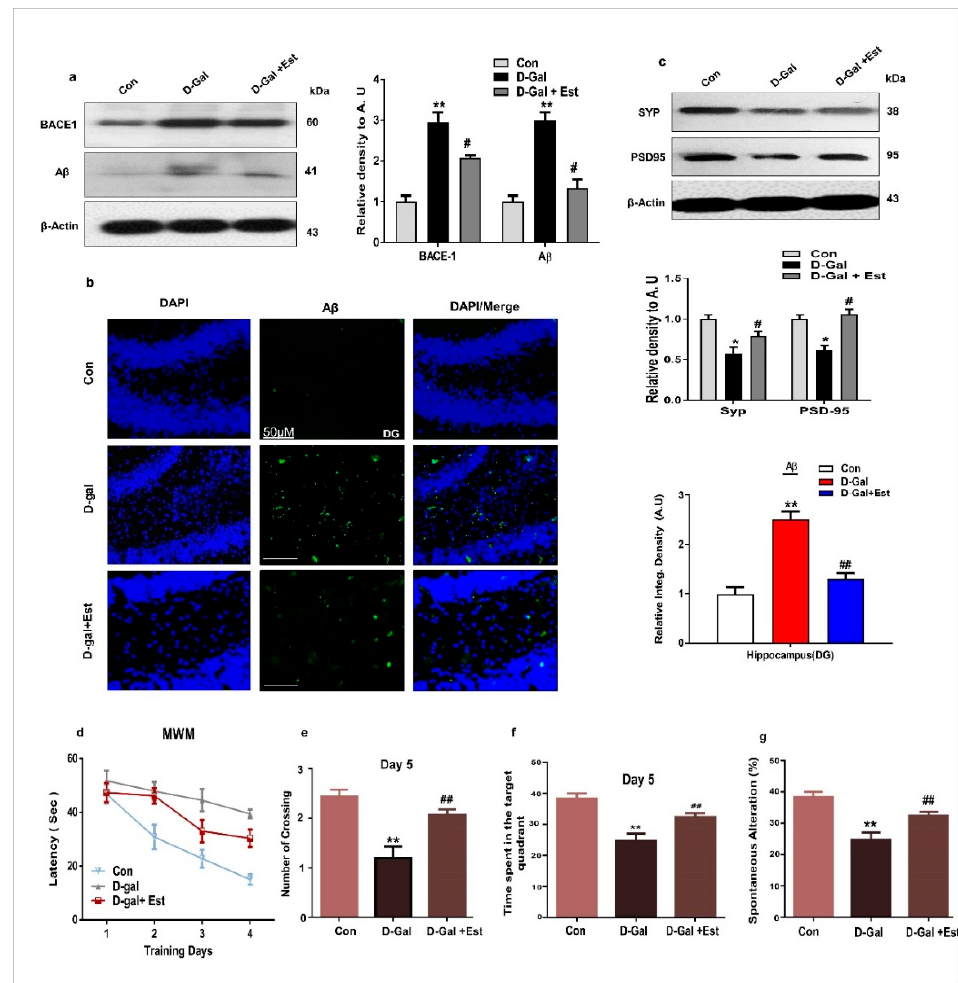
Figure 3. 17 β -estradiol reduced d -gal-induced amyloidogenic pathway upregulation and synaptic dysfunction along with memory impairment in adult mice brain. ( a ) Western blot analysis of A β proteins and beta-site amyloid precursor protein-cleaving enzyme-1 (BACE-1) in adult mice hippocampus after drug treatment. ( b ) Given are the representative images of immunofluorescence staining of Amyloid- β (A β ) (n = 7–8 mice / group). The values represent averages from three independent experiments. For immunohistological quantitative analysis, the Image-J software was used. ( c ) Western blot analysis of the presynaptic Synaptophysin (SYP) and post-synapse (i.e., PSD95) along with their respective histograms. The density values were expressed in arbitrary units (AUs) as the mean ± S.E.M. ( d ) The mean escape latency time (s) histogram during the training days. ( e ) Number of platform crossings during the probe test. ( f) Time spent in the target quadrant. ( g ) Spontaneous alternation behavior, given as a percentage (%) (n = 12–13 mice / group). The data are shown as a mean ± SEM. * significantly di ff erent from the control group and # significantly di ff erent from d -gal-treated group, respectively, * & # p < 0.05, ** & ## p <